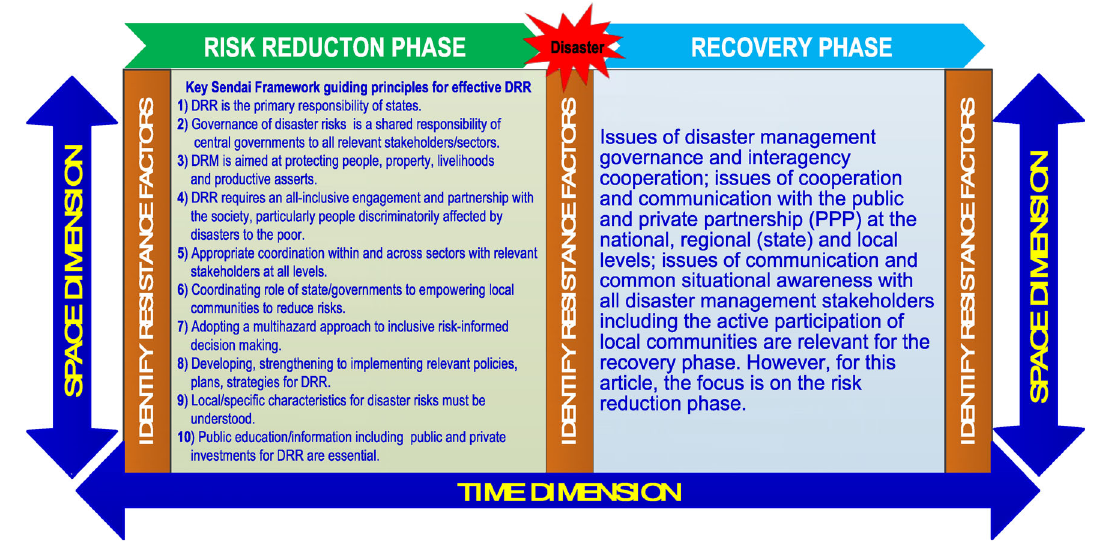
Fig. 1 The existence of resistance factors between risk reduction and recovery components of disaster management